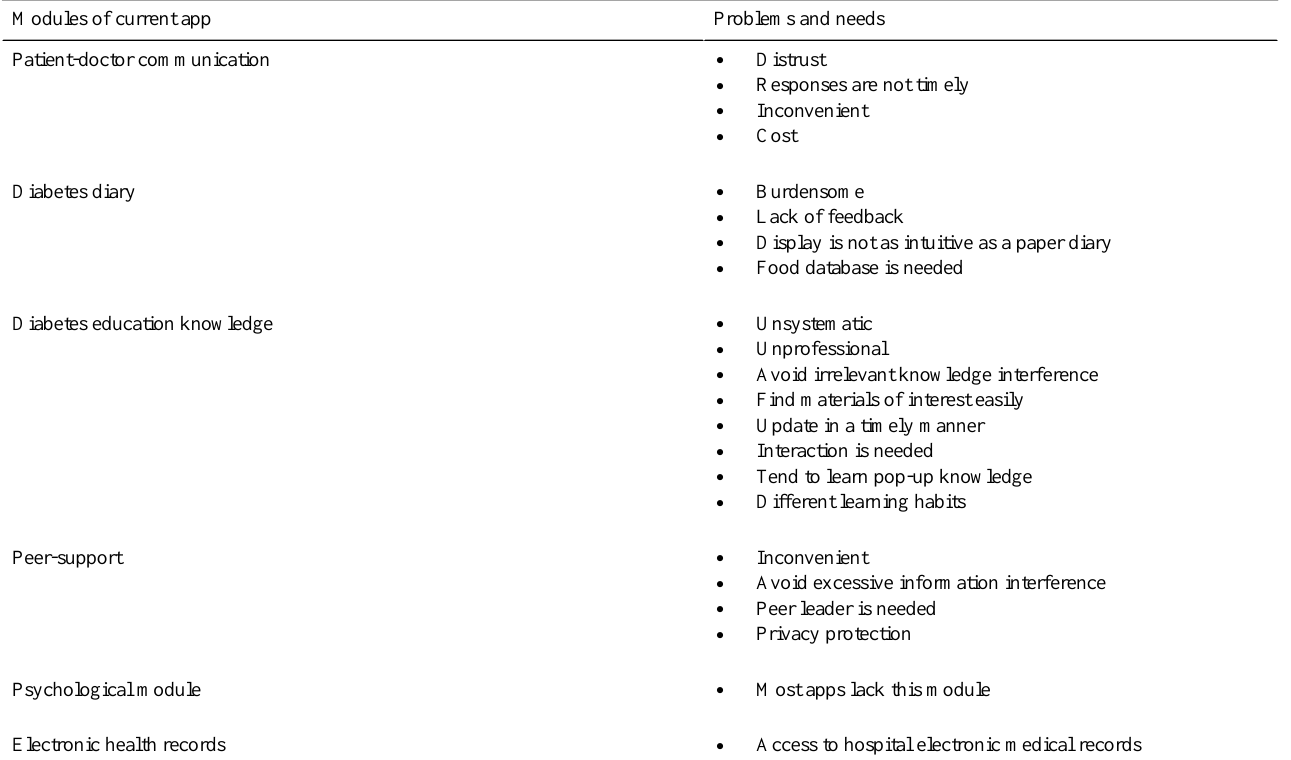
Table 3. Problems with current diabetes apps and needs for a new